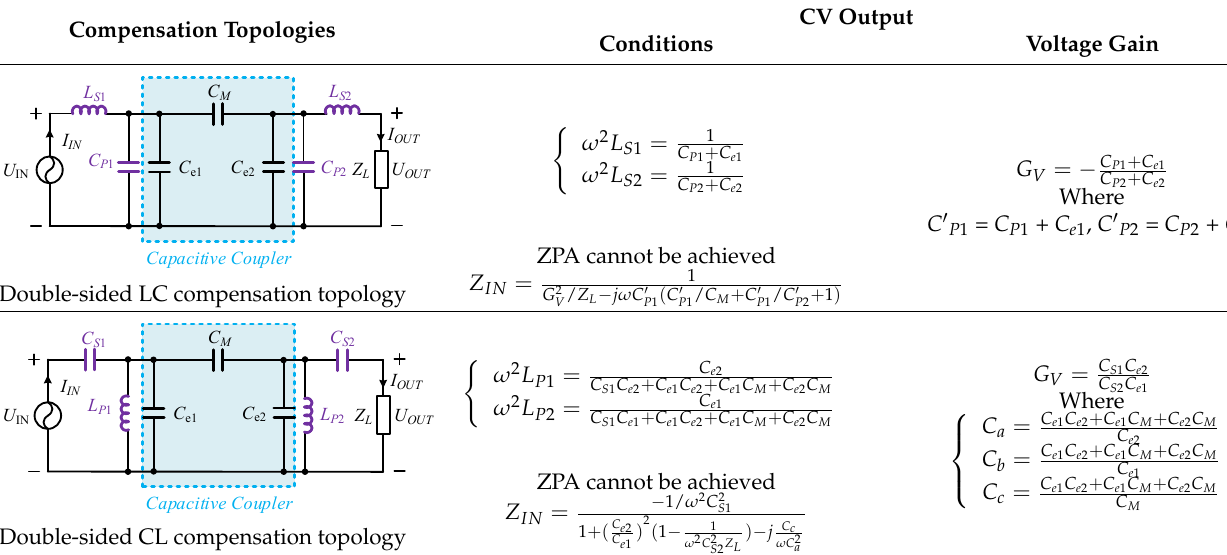
Table 3. Comparison of SP-based compensation topologies to achieve CV output.